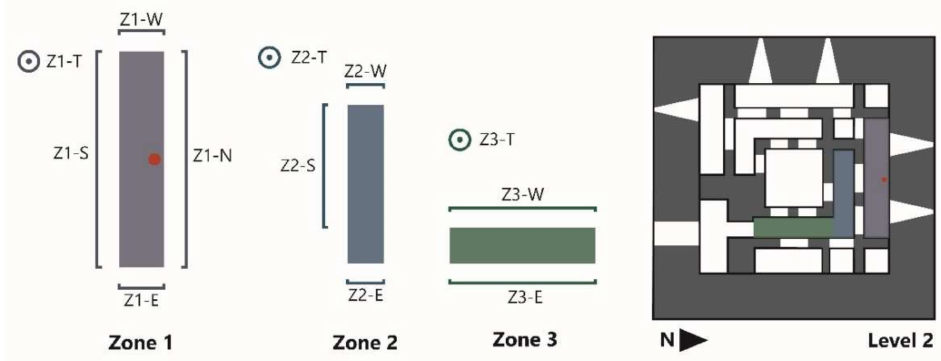
Figure 4. Zone locations for the interior blast.